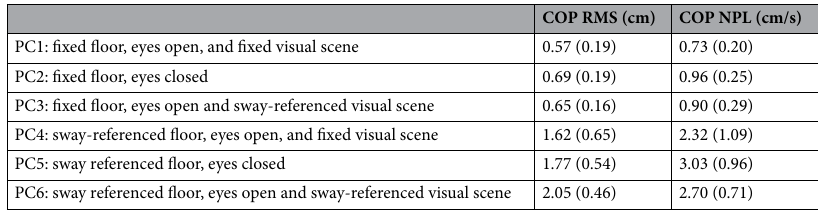
Table 3. Mean (standard deviation) of sway magnitude (COP RMS) and sway speed (COP